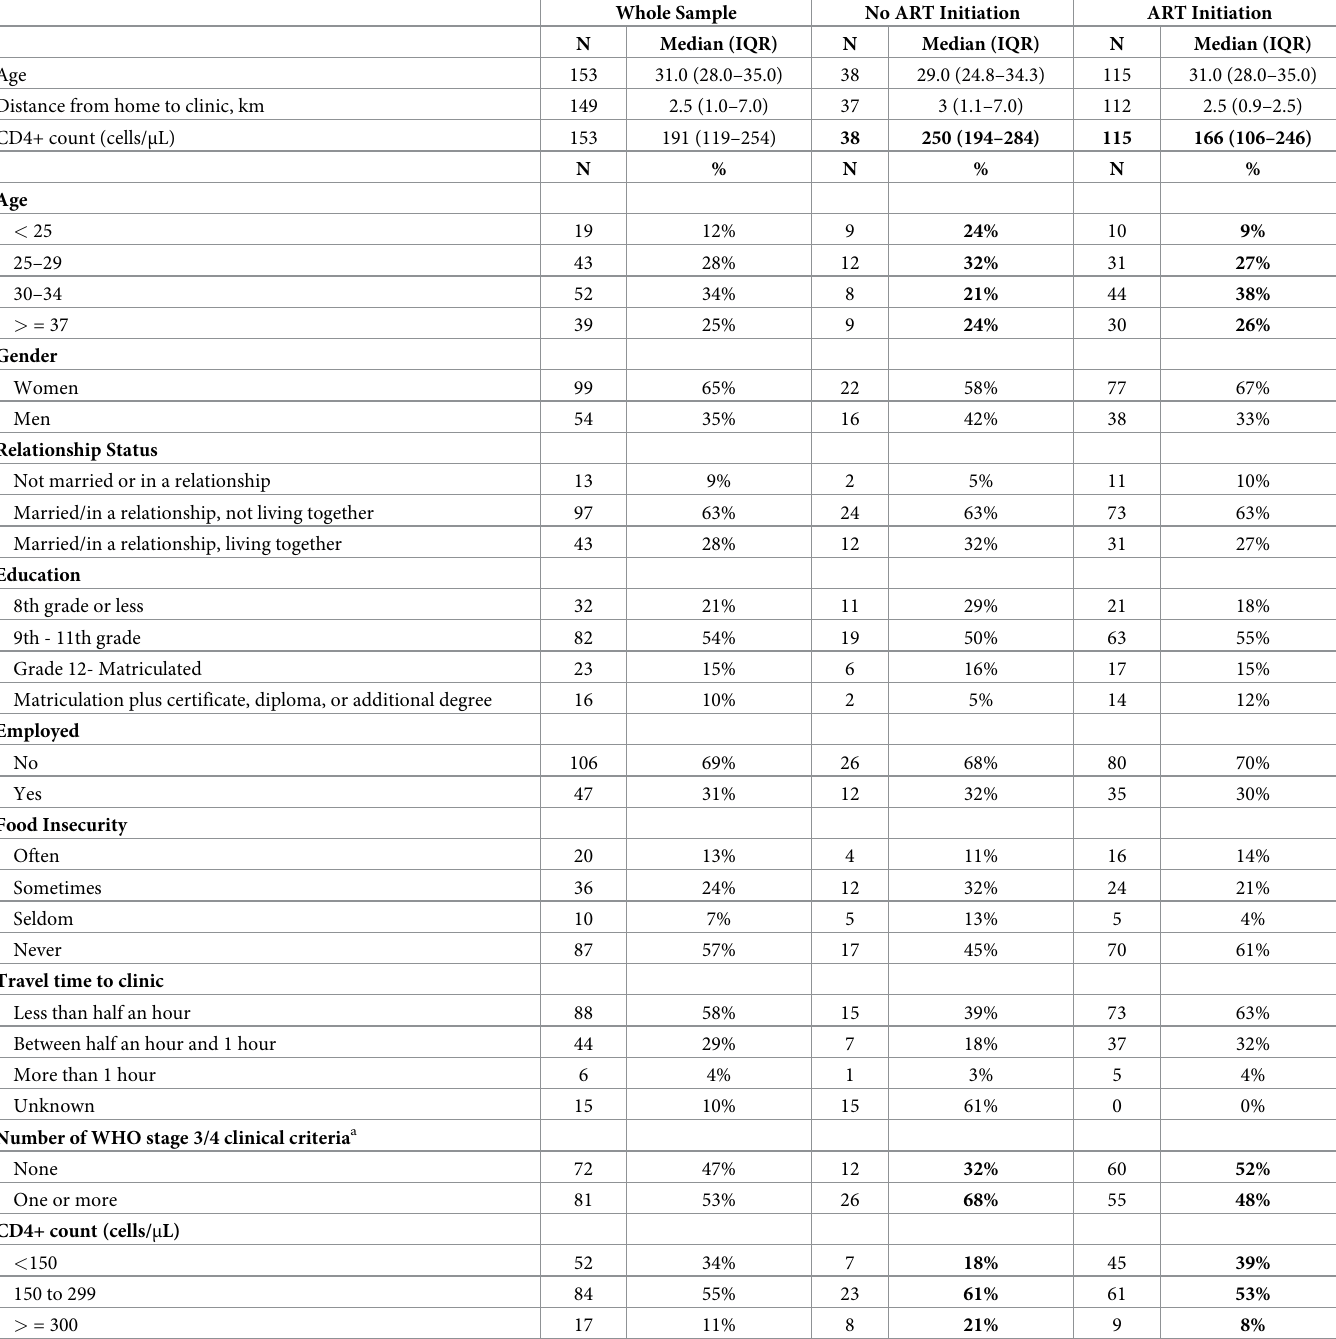
Table 1. Demographic and testing characteristics of 153 women and men living with HIV diagnosed at three primary healthcare clinics in the eThekwini, SA region, and eligible for ART at linkage to